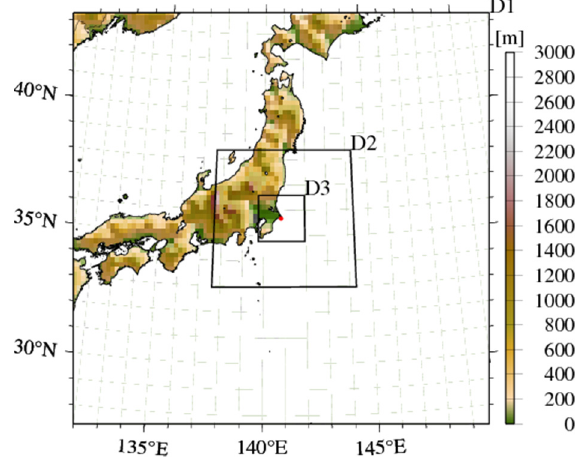
Figure 1. Domain configurations for Weather Research and Forecasting (WRF) simulations.